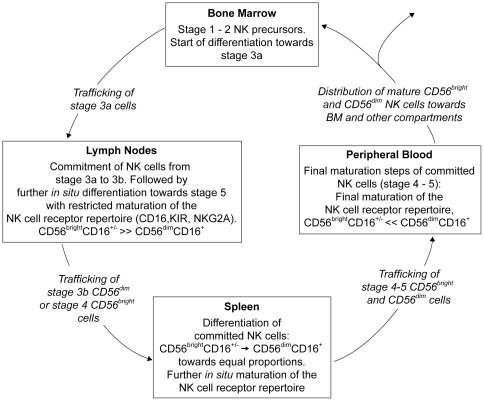
Proposed model for human NK cell development in vivo.Based on our data, we propose that precursor NK cells (stage 2) may traffic from BM to LN, where commitment to the NK cell lineage may take place (stage 3a→3b) followed by potential in situ differentiation of NK cells with restricted maturation of the NK cell receptor repertoire. For further differentiation of committed NK cells, CD56dim (stage 3b) or CD56bright cells (stage 4) may traffic towards splenic tissue in which CD56dim cells may develop and further maturation of the NK cell receptor repertoire can take place. Final maturation of NK cells may occur through trafficking of cells towards the periphery from which NK cells may be further distributed to different compartments in the human body.